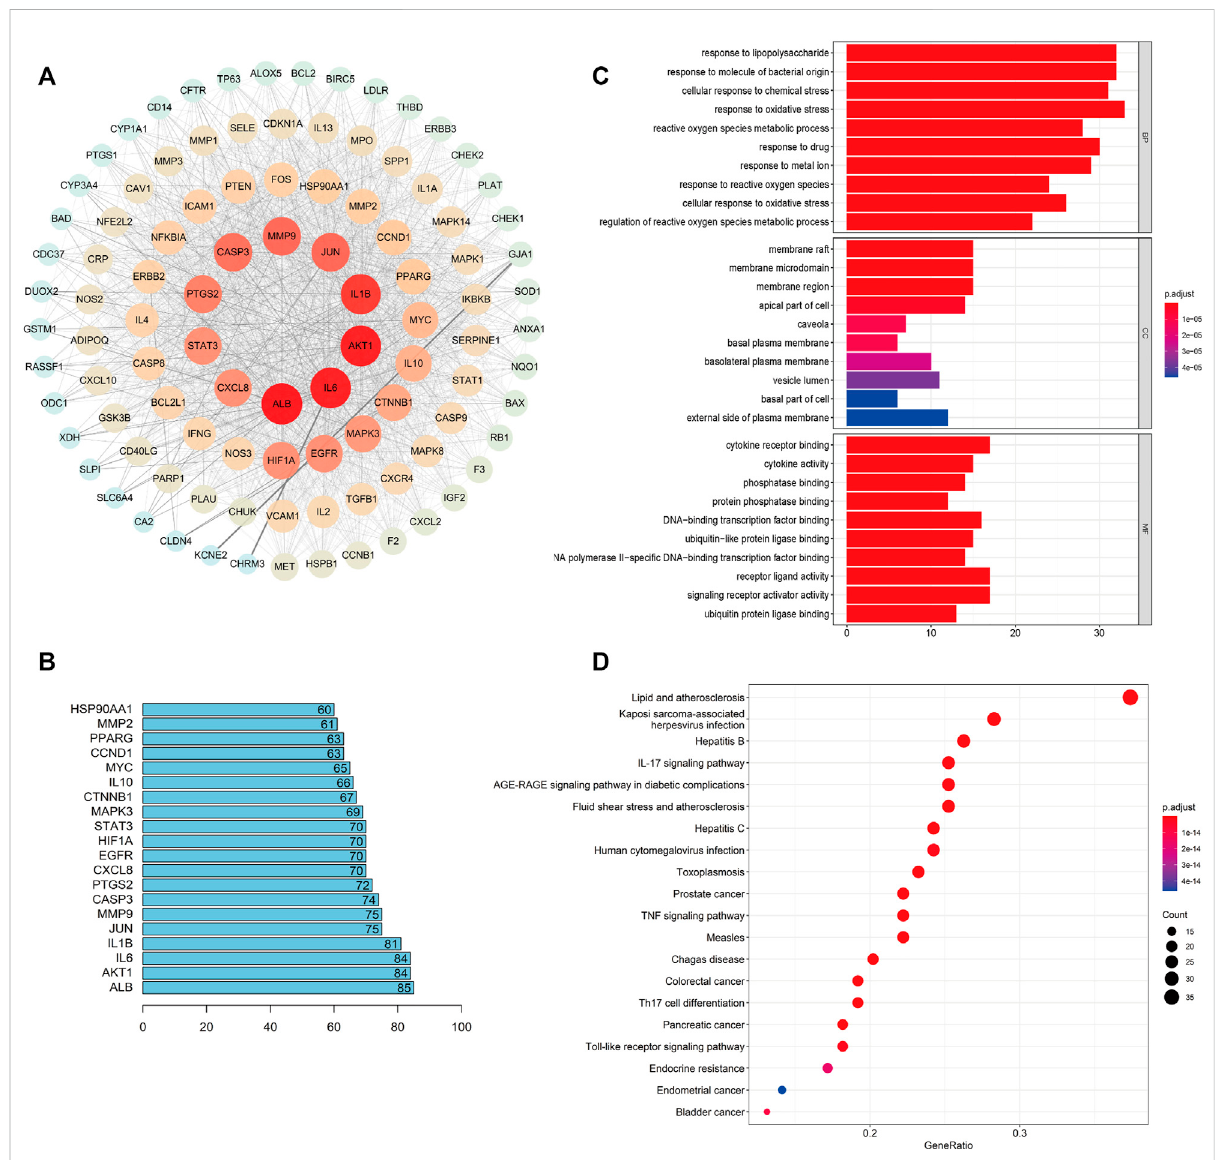
FIGURE 5 PPI Network and GO and KEGG enrichment analysis. (A) PPI network of the 102 intersection targets constructed using Cytoscape. The size of nodes represents their degree values. (B) The top 20 key targets of HQJZD in treating H. pylori gastritis. (C) All top 15 signi fi cantly enriched terms in molecular function (MF), biological process (BP), and cellular component (CC). (D) Top 20 signi fi cantly enriched terms in the KEGG